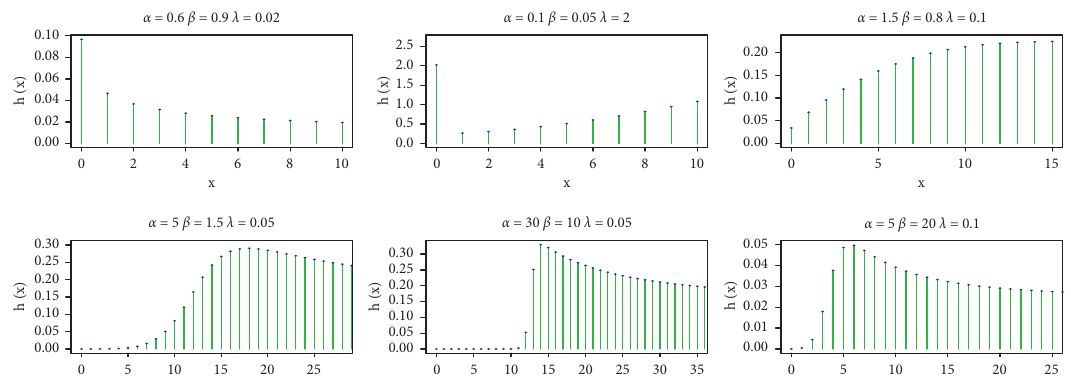
Figure 2: Different shapes’ HRF of DEOWE distribution by using different values of the parameters. These figures show that the HRF can behave in different